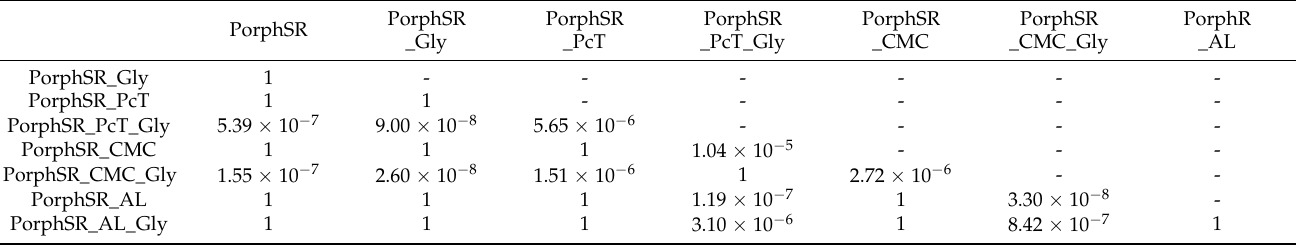
Table A7. Bonferroni pairwise comparison p -values for the different films’ fracture